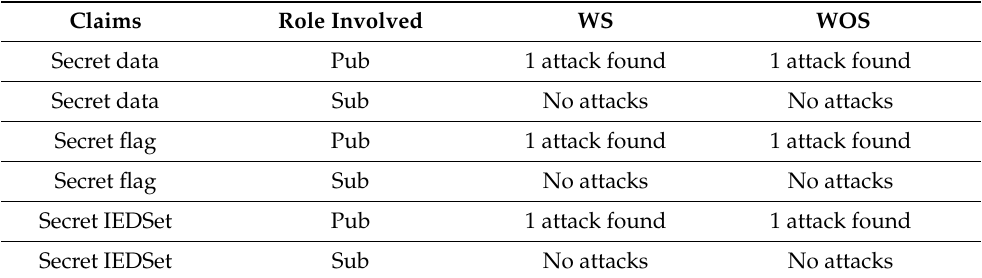
Table 7. Auto and manual security claim